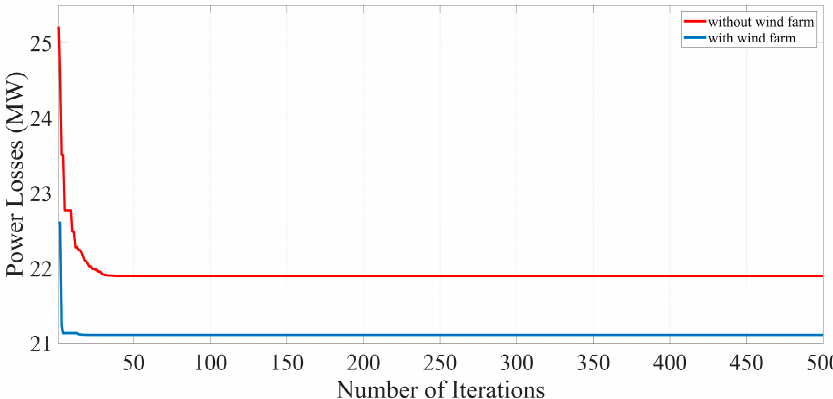
Figure 9. The convergence curves for the minimization of power losses across the transmission lines for the Test System 2.